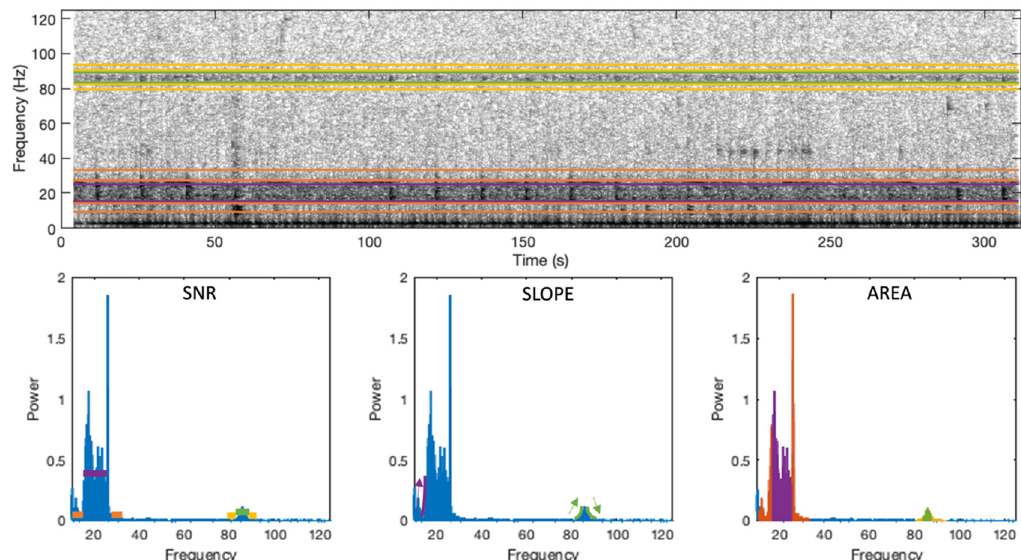
Figure 1. Illustration of the temporal-spectral appearance of the fin whale chorus and the three presented methods to detect chorus presence: the SNR method (SNR), the PSD slope method (SLOPE), and the PSD area method (AREA). Purple and green lines/fillings represent the power of the low and high frequency fin whale choruses, respectively, and orange and yellow lines/fillings represent the power of the adjacent respective noise bands. Table 1. Frequency limits for PSD operations per band. All frequency values in Hz.